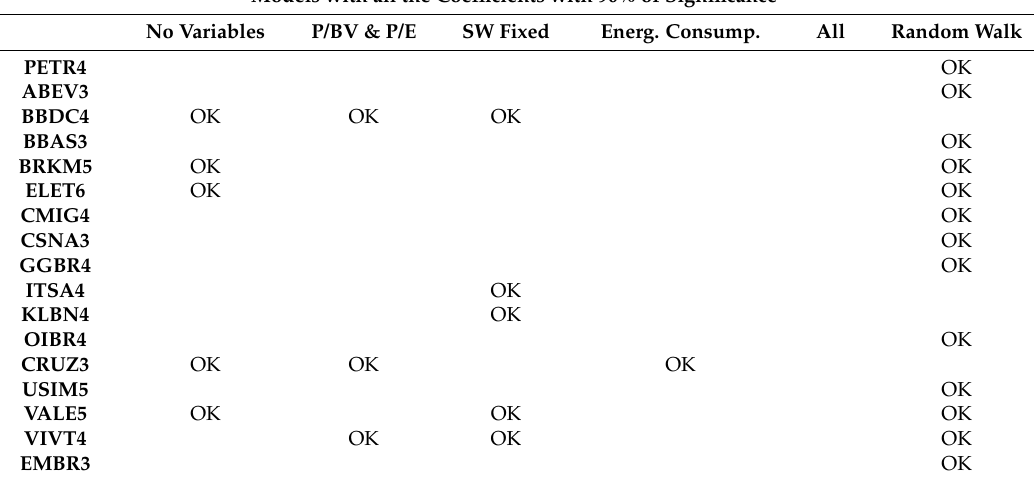
Table 2. Models with all the coefficients significant.